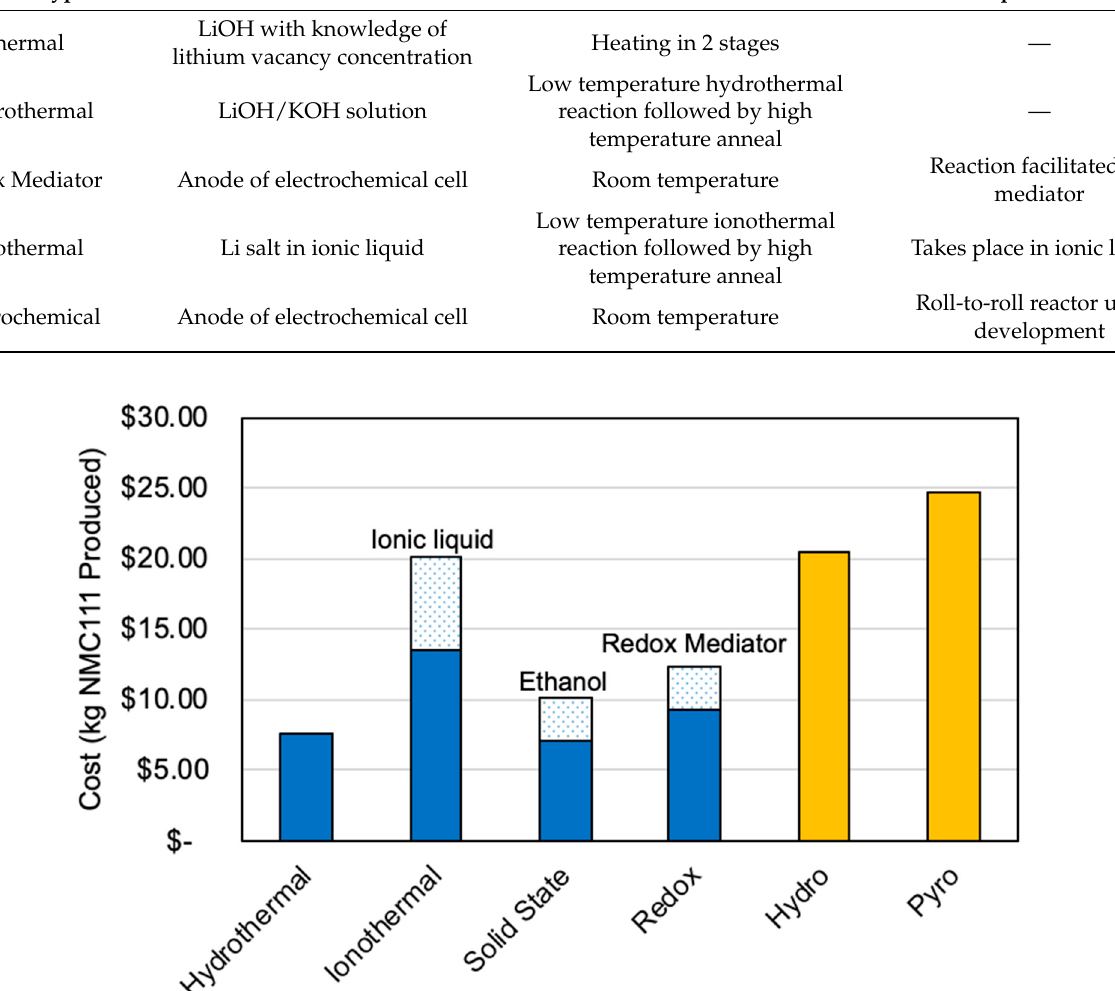
Figure 12. Cost comparison for cathode relithiated by different methods. Dotted bars represent potential cost reductions by closed-loop recycling of key materials; blue bars represent other costs for 10,000 ton/year direct recycling plants; yellow bars represent costs for 10,000 ton/year pyrometallurgical (pyro)/hydrometallurgical (hydro) recycling plants plus costs to convert recovered materials into cathode powder.